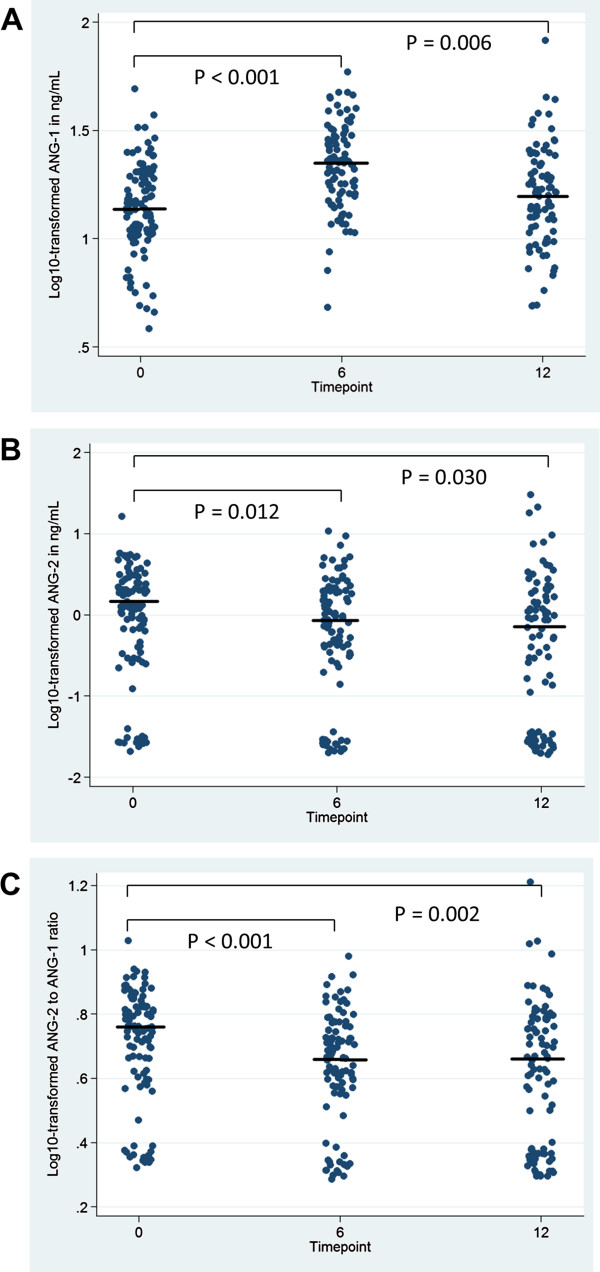
Log10-transformed Plasma Angiopoietin-1 (A), Angiopoietin-2 (B), and Angiopoietin-2:Angiopoietin-1 Ratio (C) after ART Initiation. Solid circles represent individual data points. Horizontal lines through the data points represent group median values. P values indicate pairwise comparisons between time-points (baseline, month 6, and month 12 after ART initiation) based on Wilcoxon matched-pairs signed rank tests, as presented in Table 1. There were 95 paired samples for the baseline to month 6 comparison, and 89 paired samples for the baseline to month 12 comparison. ANG-1 = angiopoietin-1, ANG-2 = angiopoietin-2.